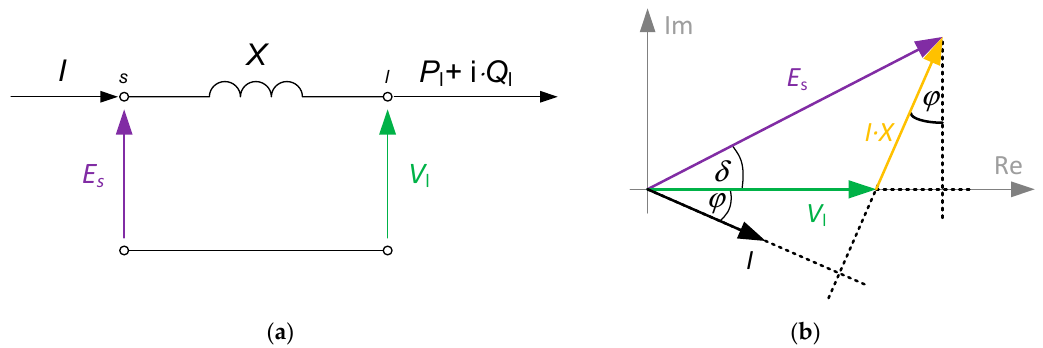
Figure 2. Power system as a source of reactive power: ( a ) equivalent circuit; ( b ) a diagram of the nodal currents and voltages of the substitute source. s—generating node; l—load node; E s , X —fictitious electromotive force and system equivalent reactance.